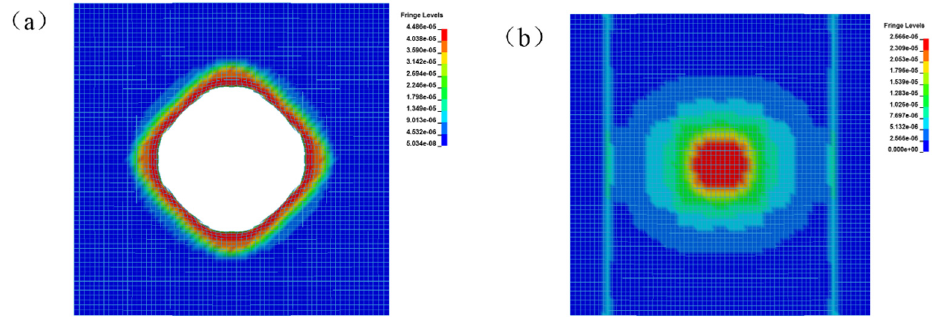
Figure 19. T26 polyurea coating stress nephograms: ( a ) face surface blast; ( b ) back blast surface.